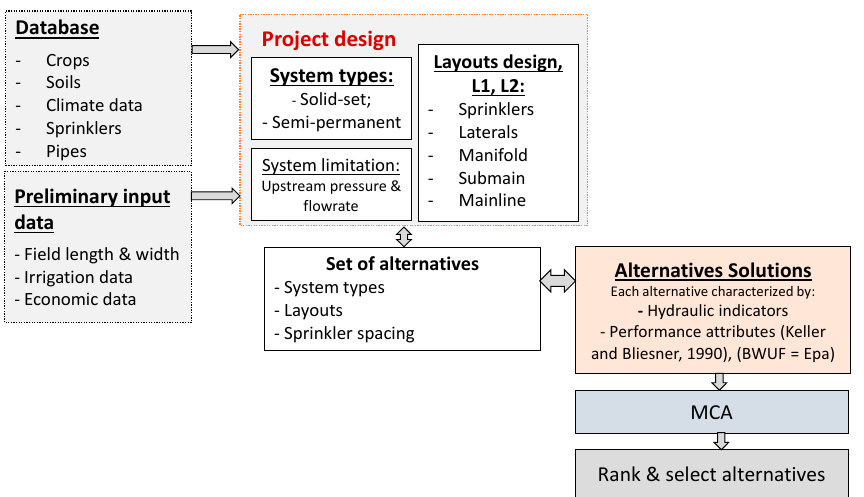
Figure 2. Schematic flow-chart of SADREG for multilevel approach for the design and application of multi-criteria ranking and selection [40].